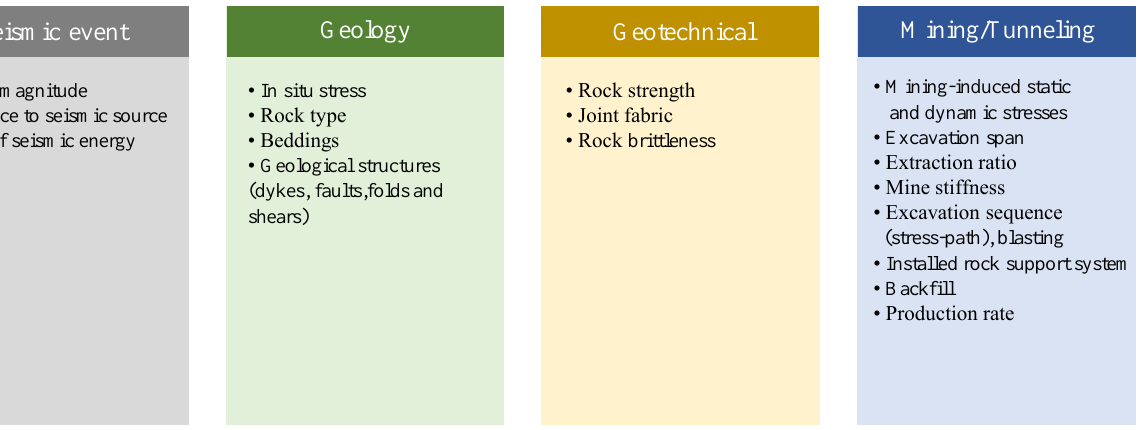
Figure 5. The main factors influencing rockburst damage and its severity (from [30]).